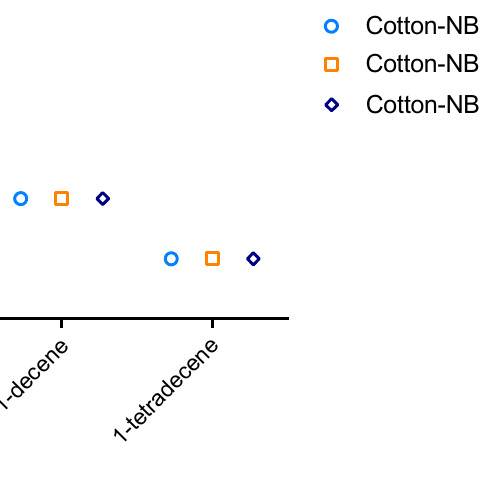
Figure 8. Results of the water shedding angle measurements of Cotton-NBB samples before and after click functionalization with either C10 or C14.